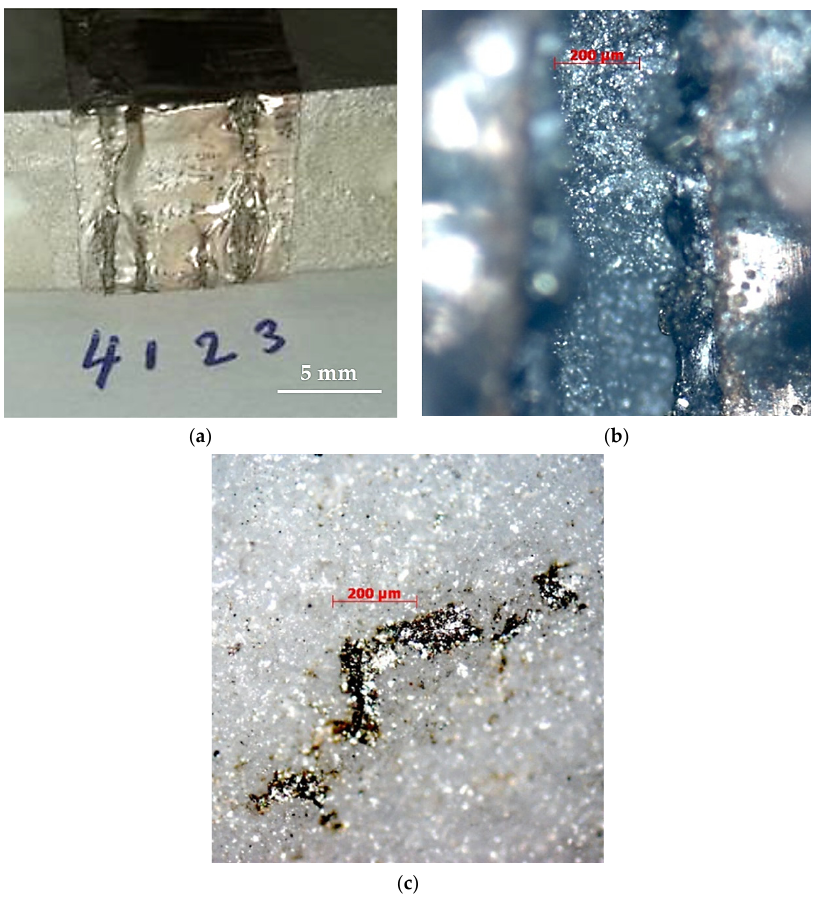
Figure 6. The preliminary testing results of the electrical discharge machining of samples with a sandwich-type mono-layer coating “silver + copper” after an hour of tempering at a temperature of 160 °C: ( a ) a sample after preliminary testing; ( b ) optical microscopy of the formed texture before coating removal, 10×; ( c ) optical microscopy of the formed texture, 10×.